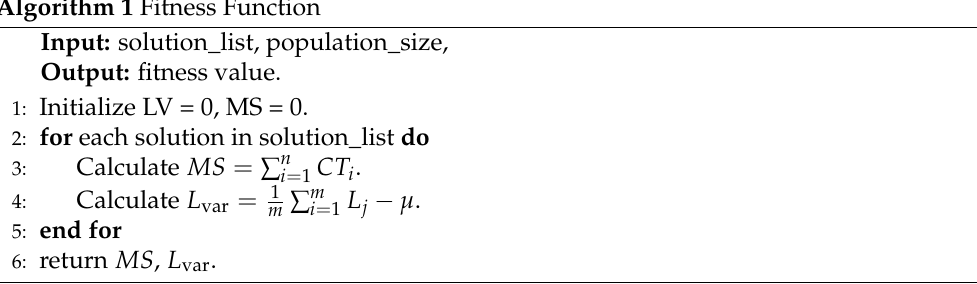
Grey Wolf Optimization